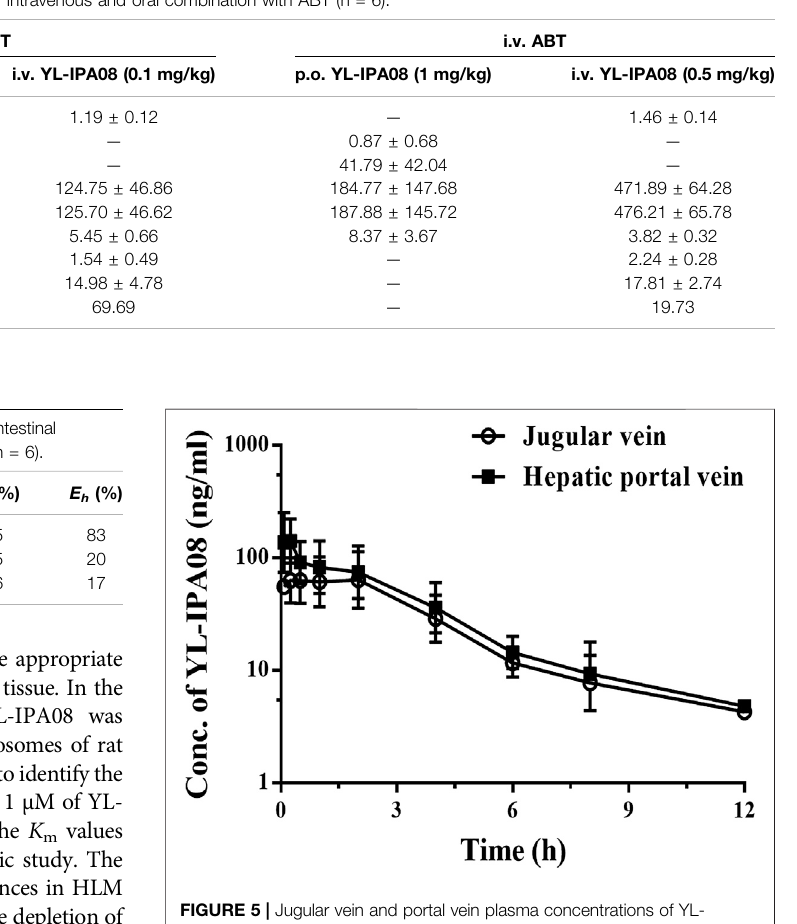
FIGURE 5 | Jugular vein and portal vein plasma concentrations of YL- IPA08 after oral administration (1 mg/kg) in double cannulated rats. Error bars represent the standard deviation of the mean concentration (n (cid:2)